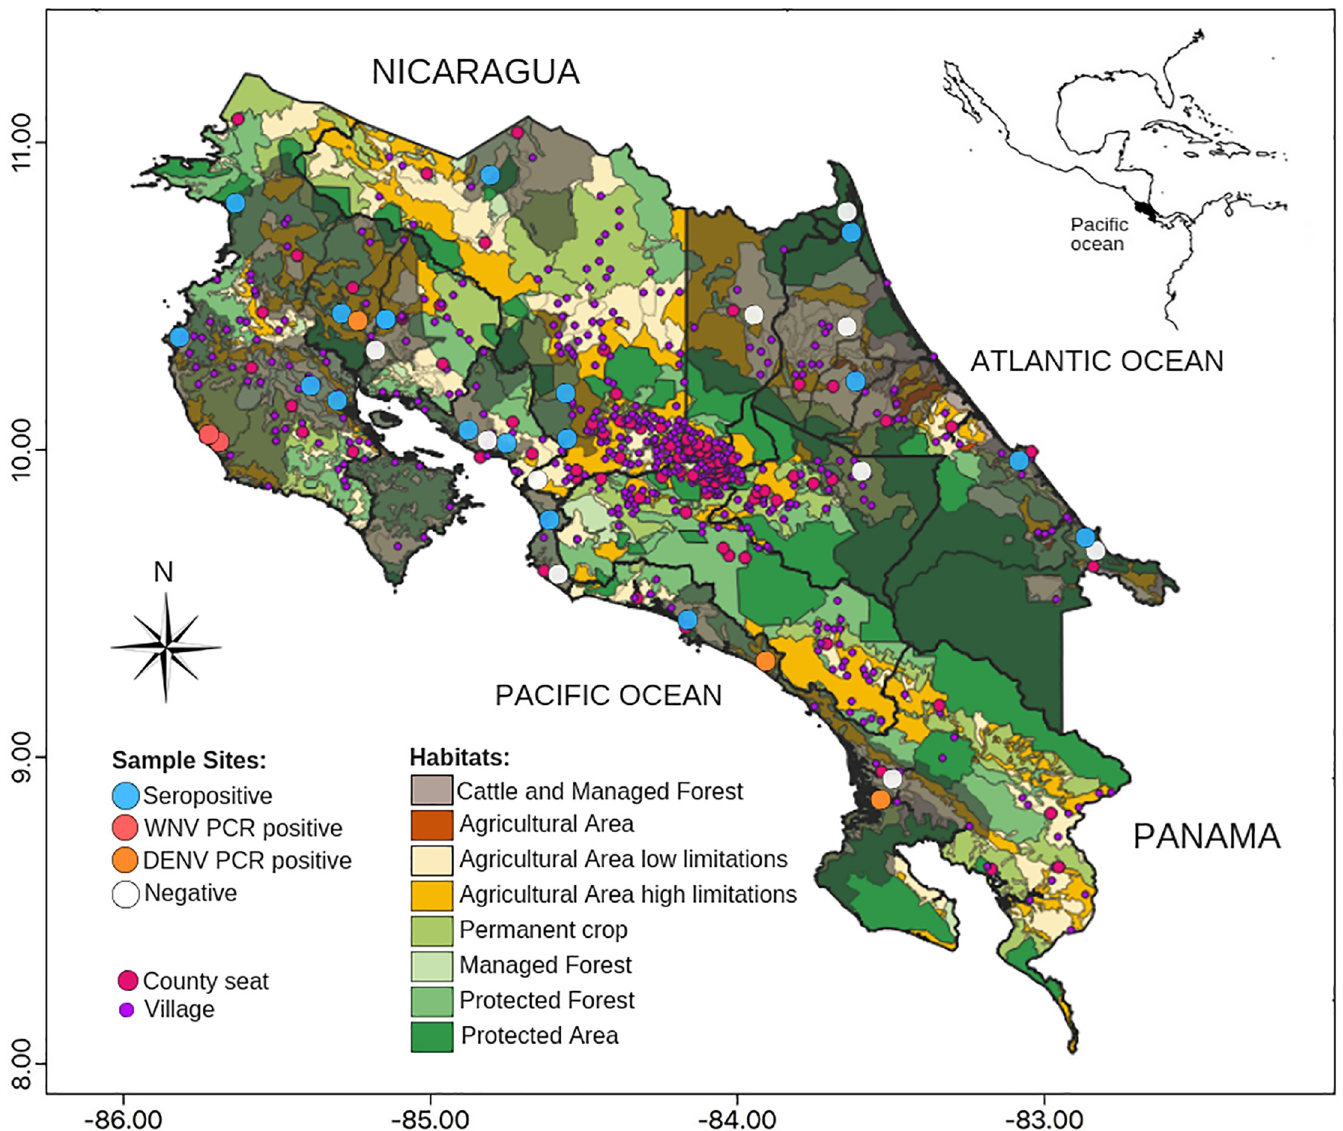
Fig 2. Sites with wild non-human primates seropositive to flavivirus, and PCR positives to DENV and WNV, 1993–2012 in Costa Rica. Reprinted from Atlas de Costa Rica under a CC BY license, with permission from Edgar Ortiz Malavasi, original copyright 2014.